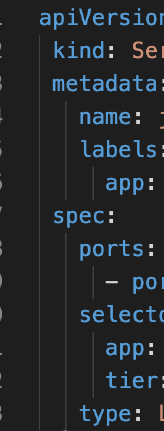
Figure 10. Single-instance JAVA deployment.